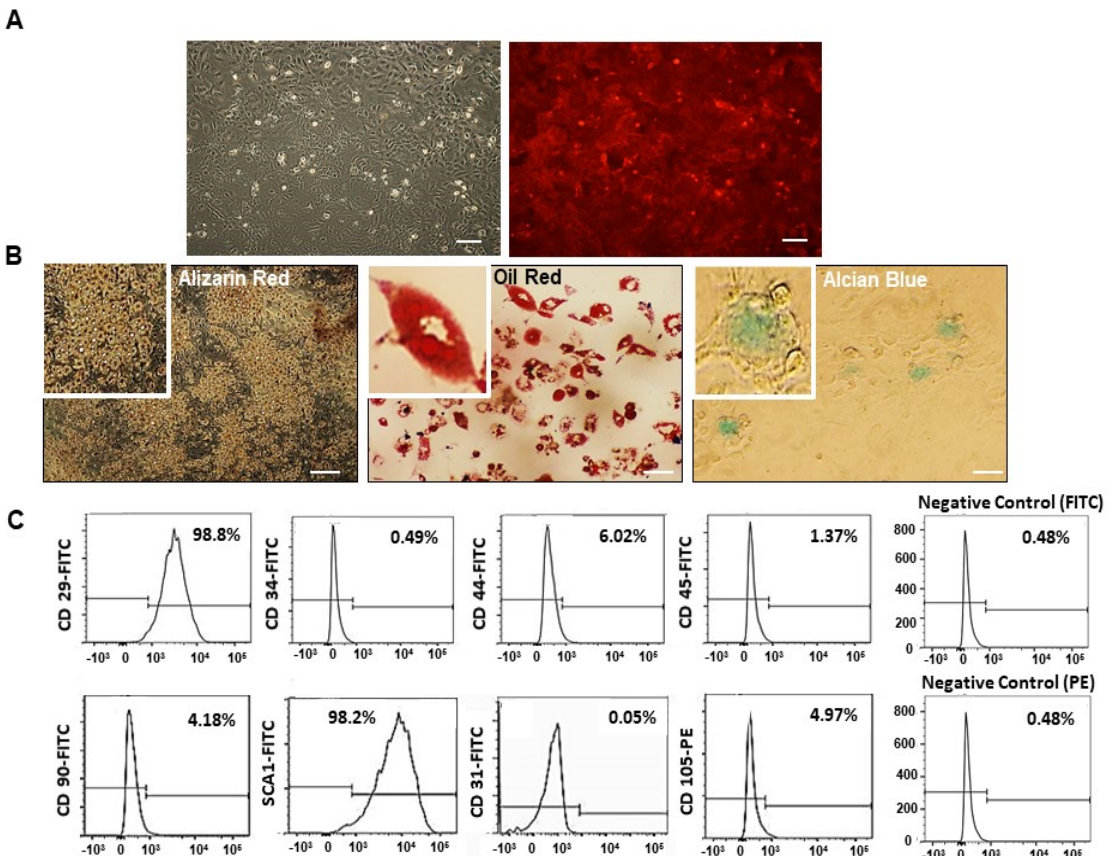
Figure 1. Characterization of bone marrow-derived mesenchymal stem cells (MSC) isolated from mTmG mice. ( A ) Plastic adherent cells were ex vivo expanded until passage 10, maintaining red fluorescent (RFP) expression throughout. ( B ) MSCs differentiated into osteogenic (alizarin red staining), adipogenic (oil red staining), and chondrogenic (alcian blue staining) lineages. Scale bars represent 200 µ m. ( C ) Flow cytometry analysis for immunophenotyping showed that MSCs, in passages 7–8, were positive for CD 29 (98.8%), SCA-1 (98.2%), CD 44 (6.02%), CD 90 (4.18%), and CD 105 (4.97%), and negative for CD34 (0.49%), CD 45 (1.37%), and CD 31 (0.05%).